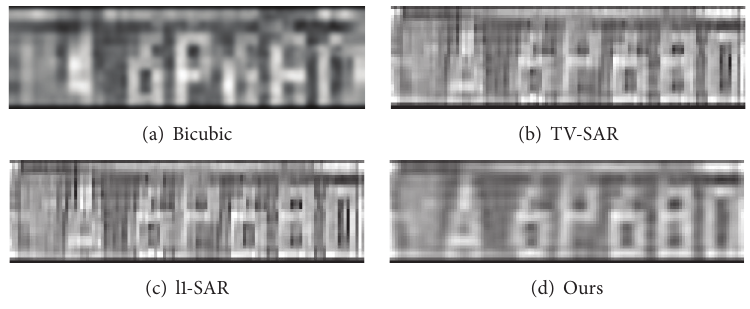
Figure 15: The reconstructed results for the second LR license plates.